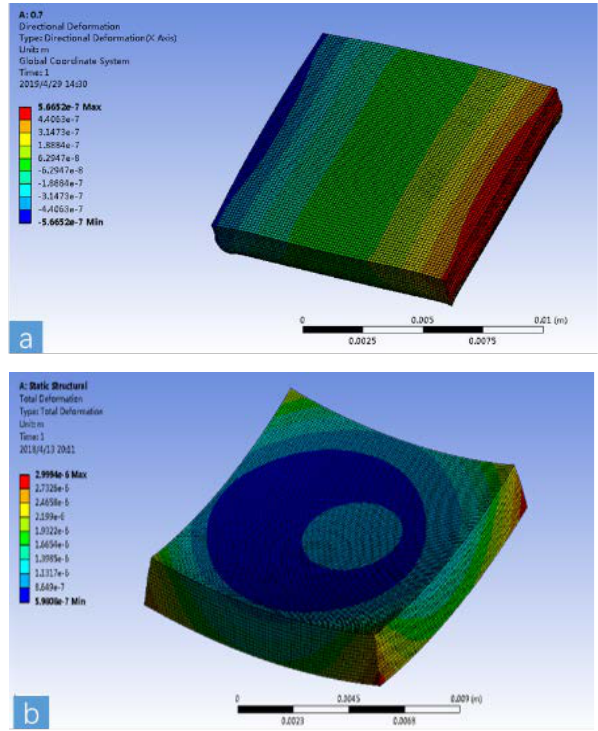
Figure 4. Two simulation results for a total silicon thickness of 335 µ m: ( a ) fixed support at the bottom, constrained expansion; ( b ) free expansion, no boundary constraints.